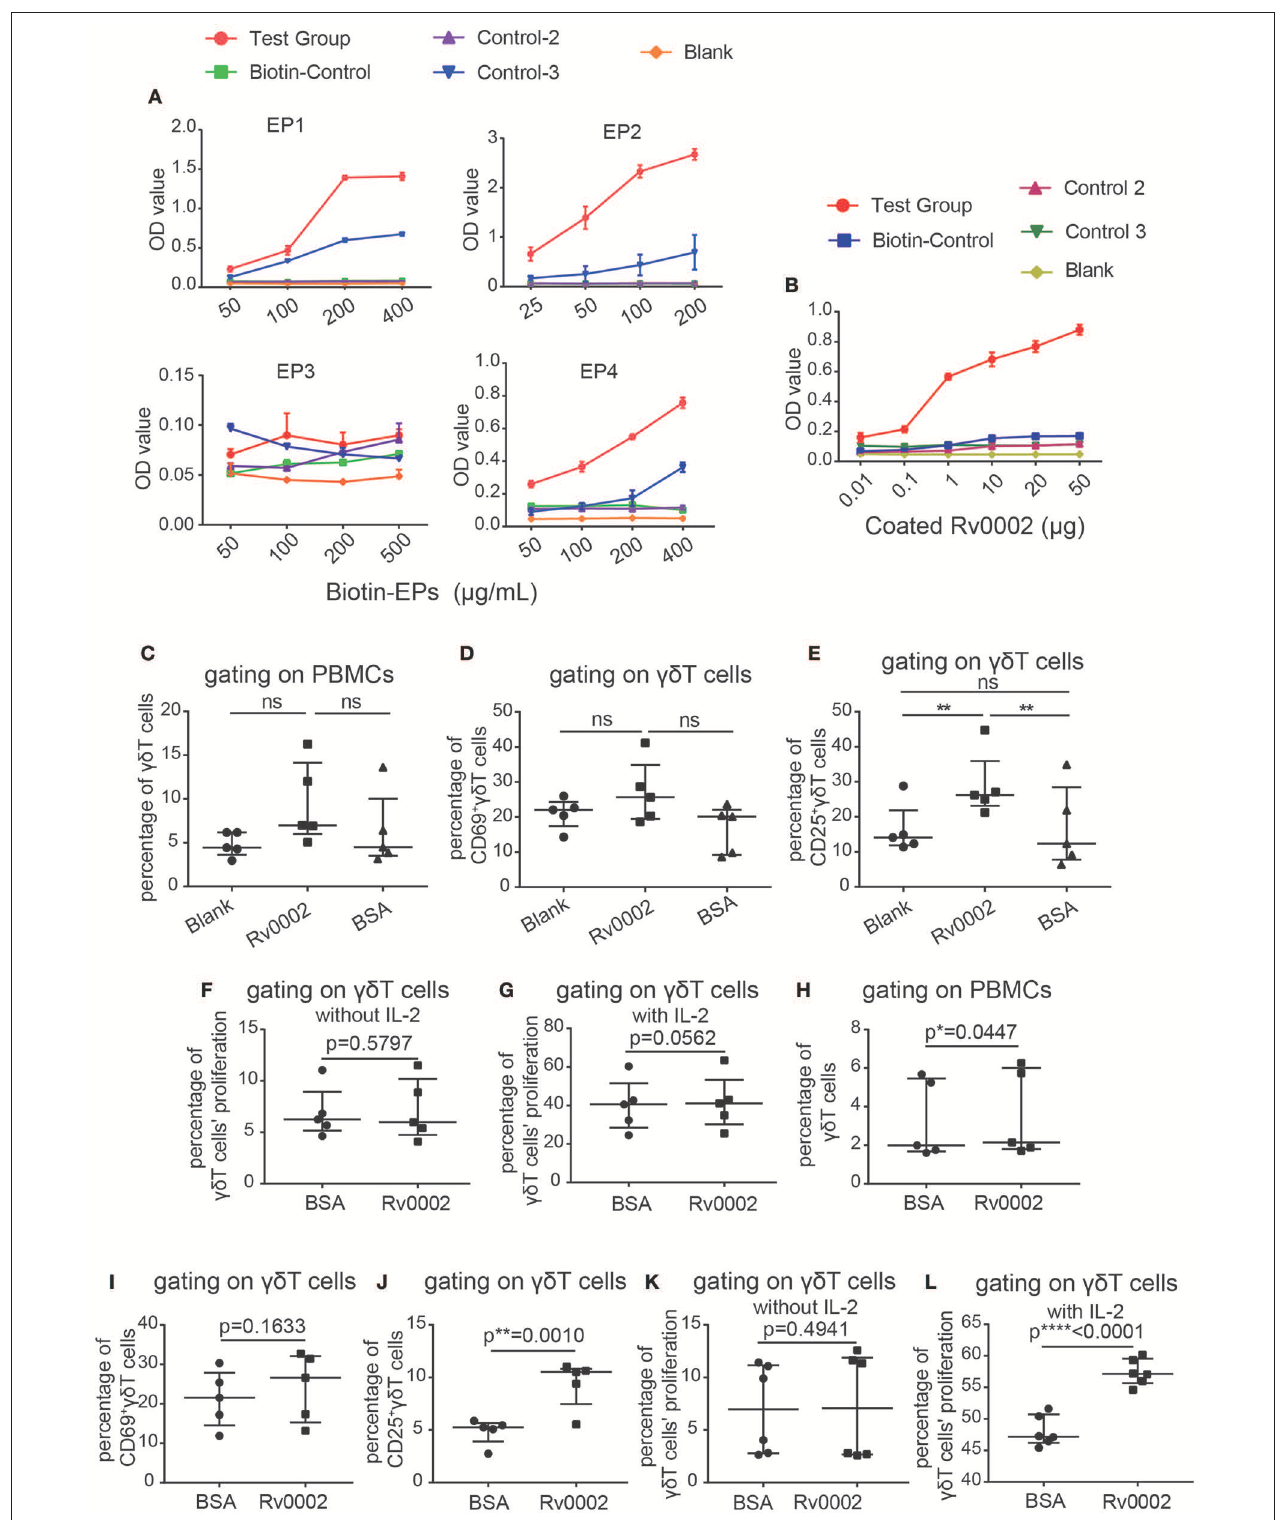
FIGURE 6 | Epitopes/Rv0002 stimulated the activation and proliferation of γδ T cells in vitro . (A,B) Binding curve of the epitopes (A) and the Rv0002 protein to the CDR3 δ probe (B) by ELISA. (C–E) Quantification of the proportions of γδ T cells (C) , CD69 + γδ T cells (D) and CD25 + γδ T cells (E) in PBMCs of healthy